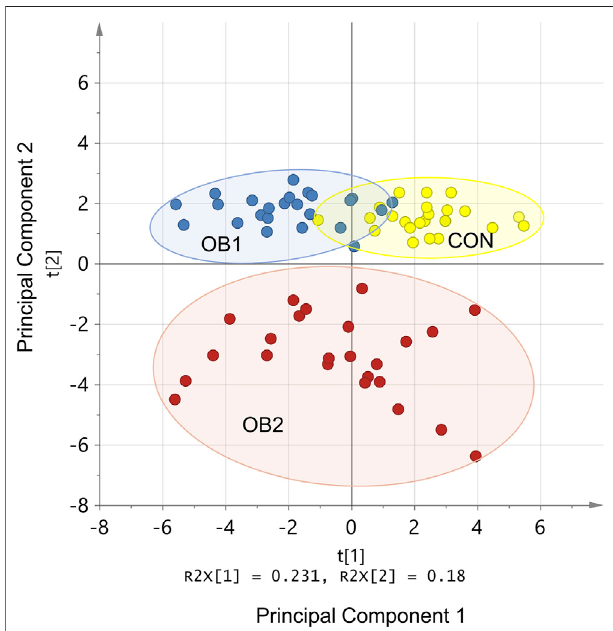
FIGURE 1 | PCA model standardised scores plot. R2x[1] and R2x[2] indicate the proportion of variance explained by the fi rst and second principal components,respectively.Onlythe fi rstandsecondprincipalcomponentsare shown. The coloured dots (individual rats) indicate dietary group membership (CON = yellow, OB1 = blue, and OB2 = red) and the ellipses indicate the 95% con fi dence interval for each data set.